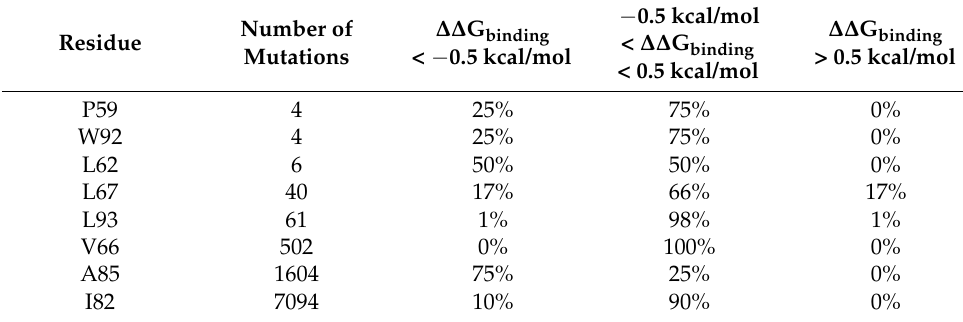
Table 8. Summary for predicted interfacial residues that interact with the second probe. Number of Residue